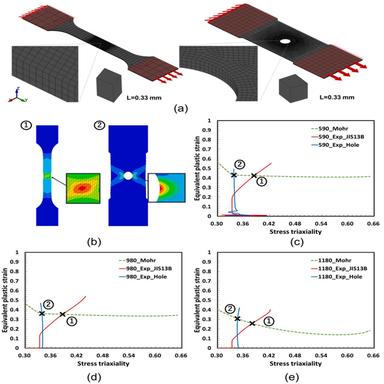
Stress triaxiality dependence of equivalent plastic strain fitted by modified Mohr–Coulomb model. (a) FEM models and boundary conditions; (b) distribution of equivalent plastic strain and critical elements of JIS13B and hole-notched FEM model; fitted fracture criteria of (c) JSC590, (d) JSC980, and (e) JSC1180.